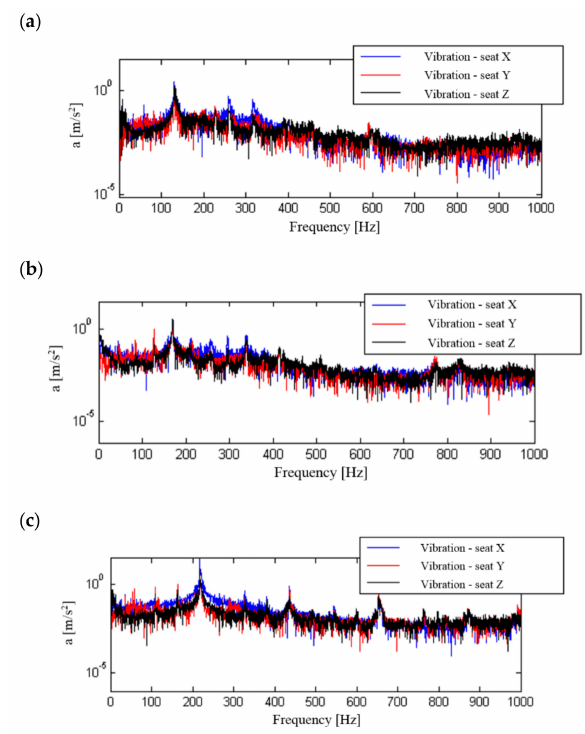
Figure 10. Frequency analysis of general vibration (seat) in the X, Y and Z directions: ( a ) speed 50 km / h,